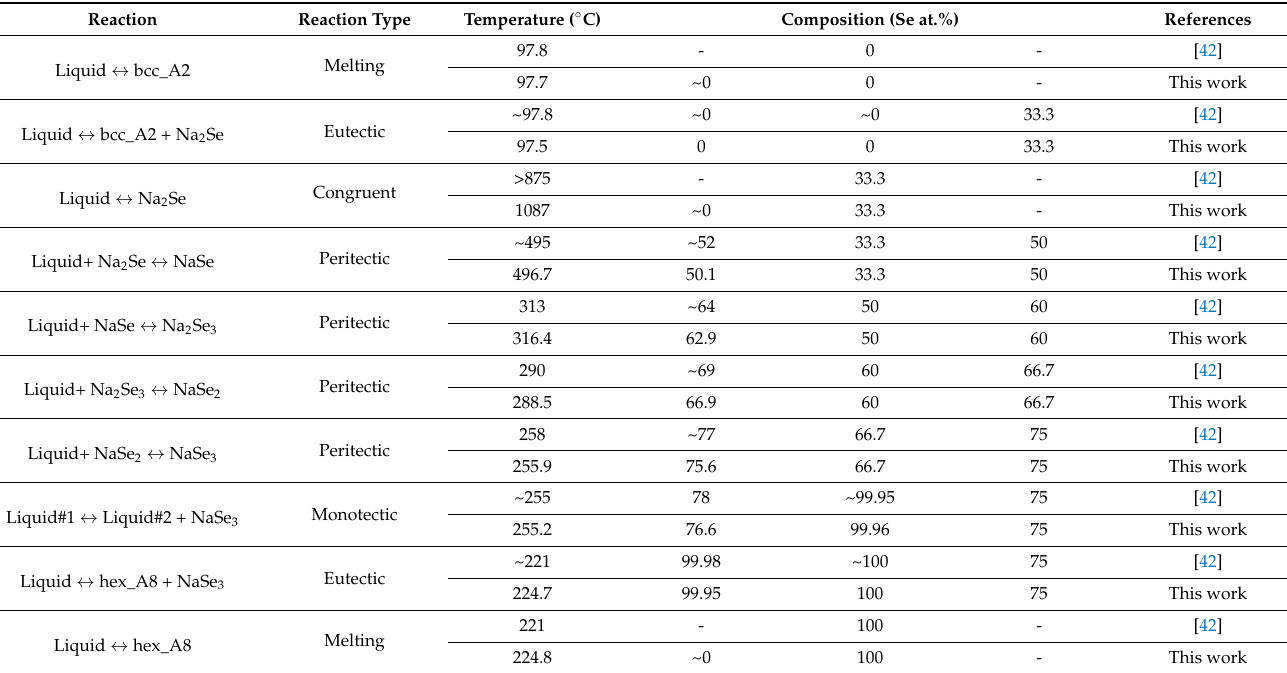
Table 6. Calculated invariant reactions in the Na-Se system compared with the experimental data [42]. Composition (Se at.%)